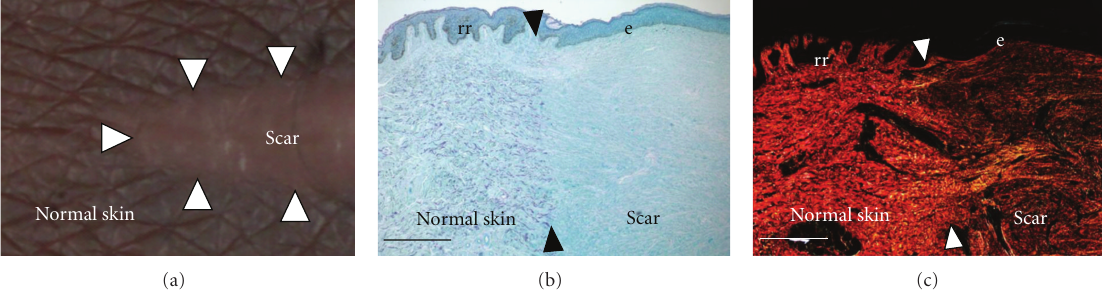
Figure 1: Scarring results from an abnormal deposition and organisation of collagen cutaneous scar in a noncaucasian subject at 12 months following a 1 cm full thickness incision to the inner aspect of the upper arm (a). Histological staining of the excised scar with Van Gieson’s stain demonstrating collagen (blue/green) and elastin (purple) staining in the normal skin compared to scar tissue and a normal undulating epidermis with rete ridges in the normal skin compared to a flattened epidermis overlying the scar (b). Picrosirius red staining of the same scar viewed using polarised light (c), illustrating the normal “basket-weave” organisation of collagen in the normal skin resulting in organised light scattering (birefringence) compared to the abnormal organisation of collagen fibres within the scar resulting in a lack of birefringence. Arrowheads indicate the border of normal skin and scar tissue. Scale bars in (b) and (c) are 500 mm. In (b) and (c), rr = rete ridges; e = epithelium.